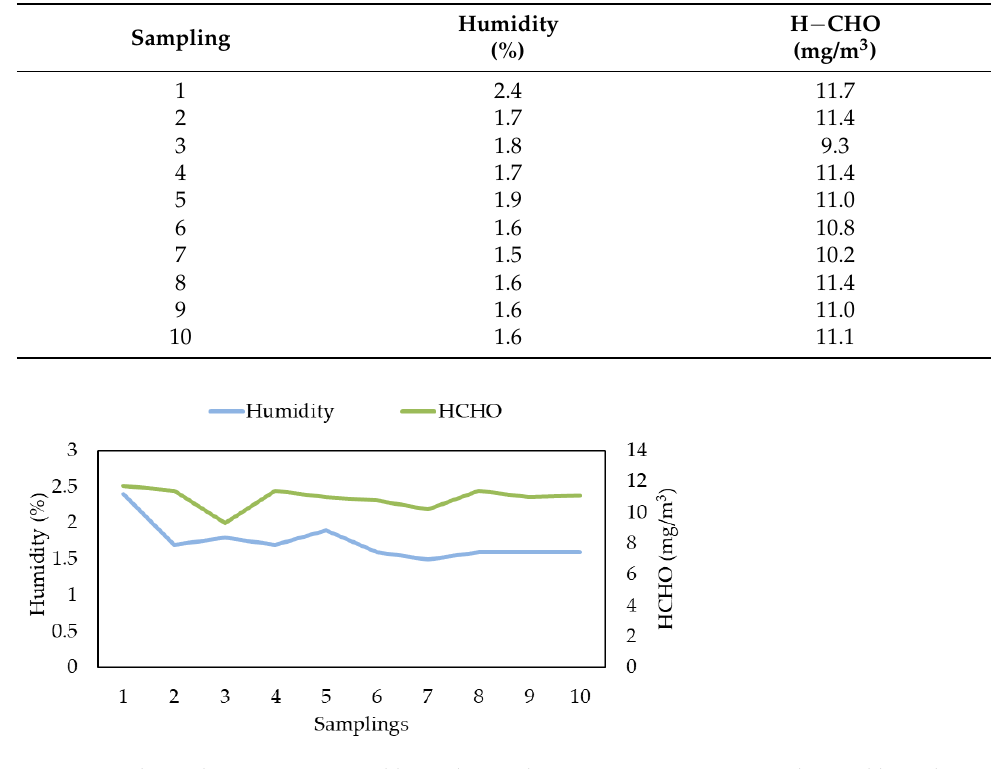
Figure 3. Relation between measured humidity and H−CHO concentrations obtained by Lab. RSE during Second Campaign.